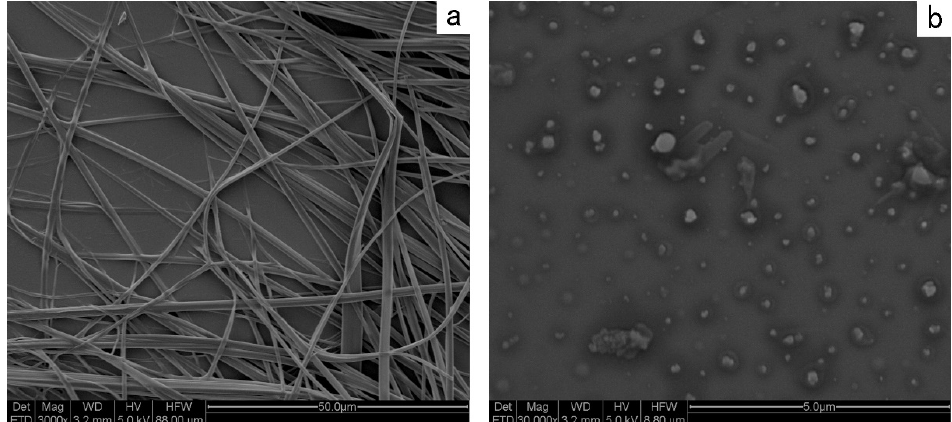
Figure 5. SEM of the D-Azo-D 230 fibers ( a ) and residual solution of the hydrogel ( b ).